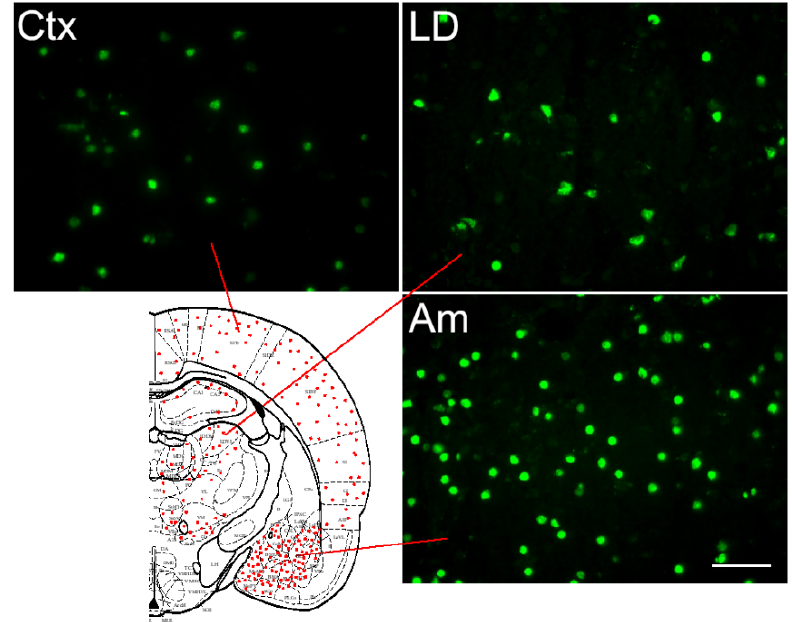
Figure 6. TUNEL labeling, indicative of apoptotic cells, in the cerebral cortex (Ctx), laterodorsal thalamic nucleus (LD), and amygdala (Am), and the distribution of TUNEL-positive apoptotic cells in a coronal section of rat brains (at a Bregma level − 3.14 of the atlas of Paxinos and Watson (1986) [50]) 24 h after the onset of pilocarpine-induced status epilepticus.